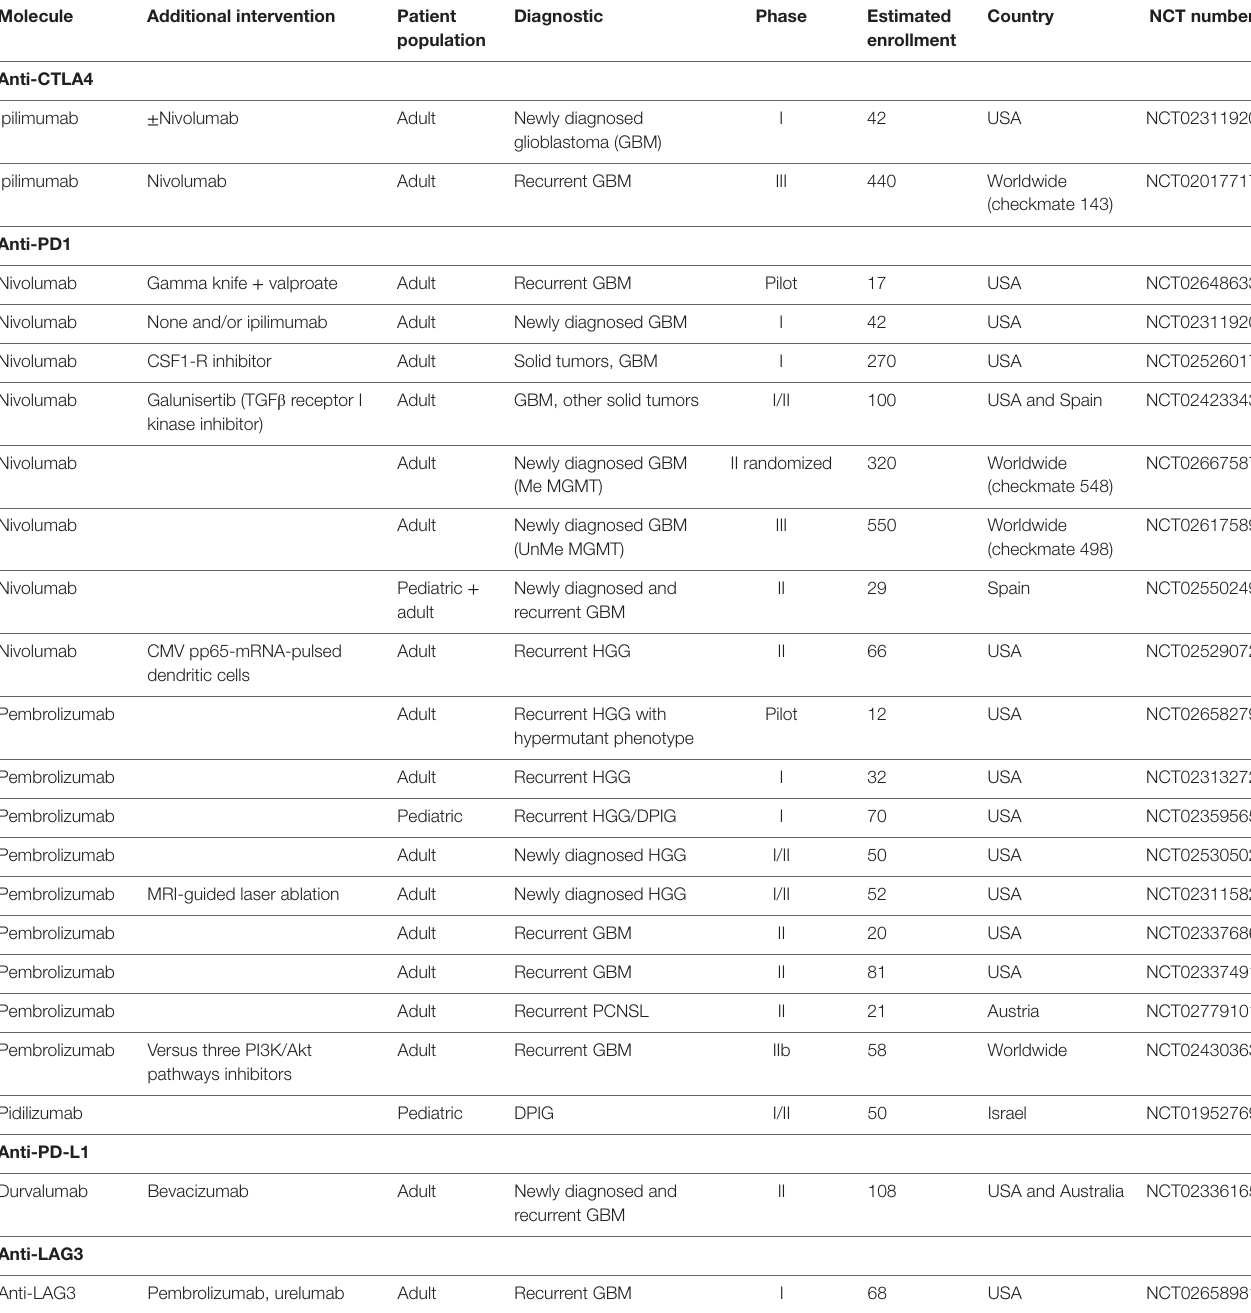
TABLe 4 | Currently ongoing immune checkpoint